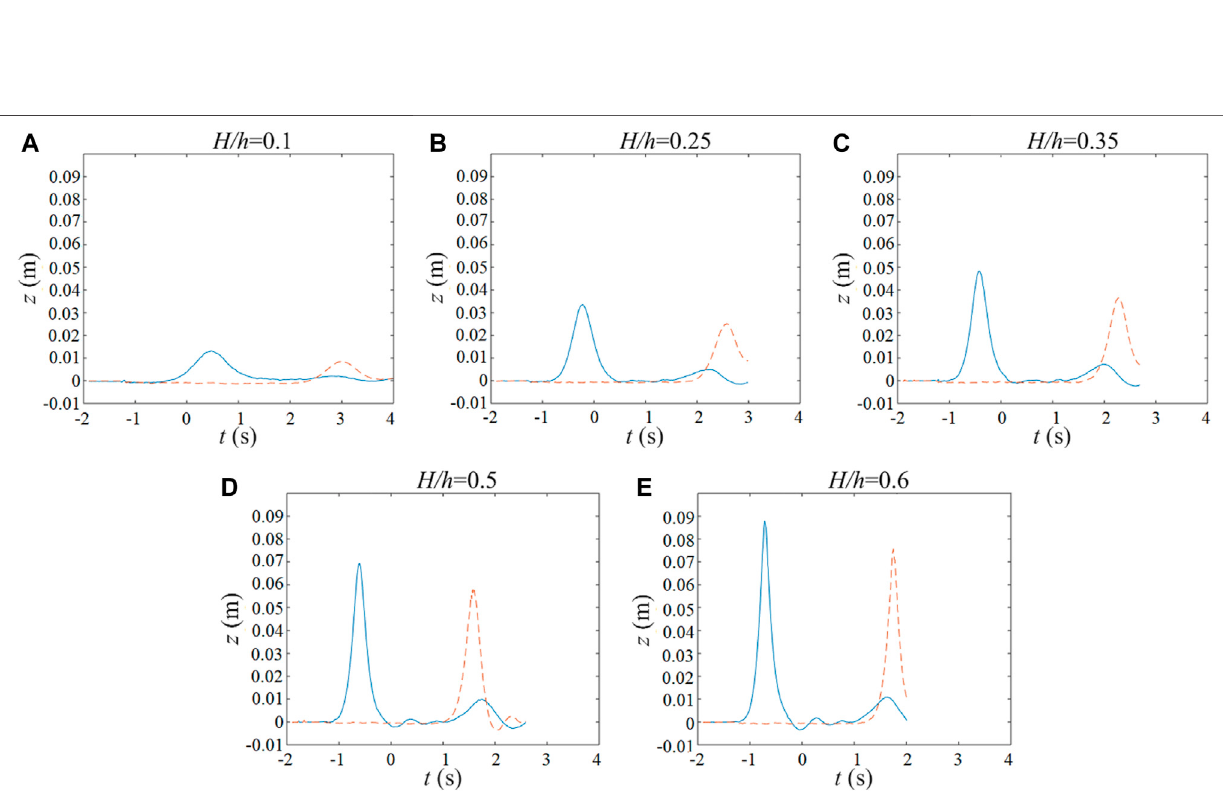
Frontiers in Environmental Science |